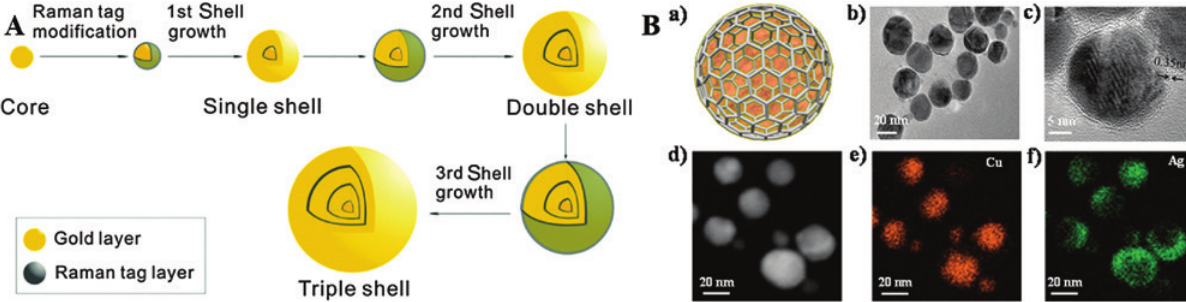
Figure 3: (A) Schematic illustration of the synthesis of nanomatryoshkas (NMs) with single, double and triple Au shell layers. Adapted from Lin et al. Chem. Commun. 2015 , 51 , 17740–17743, with permission from the Royal Society of Chemistry. (B) Advanced structural analysis of AgCu-graphene (ACGs) NPs. (a) Schematic diagram, (b) TEM image, (c) HR-TEM image, and (d–f) STEM images of ACGs. Adapted from Song et al. J. Am. Chem. Soc. 2014a , 136 , 13558–13561. Copyright © 2014 American Chemical